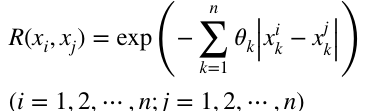
Fig. 4 Fitting results of the surrogate model and the simulation